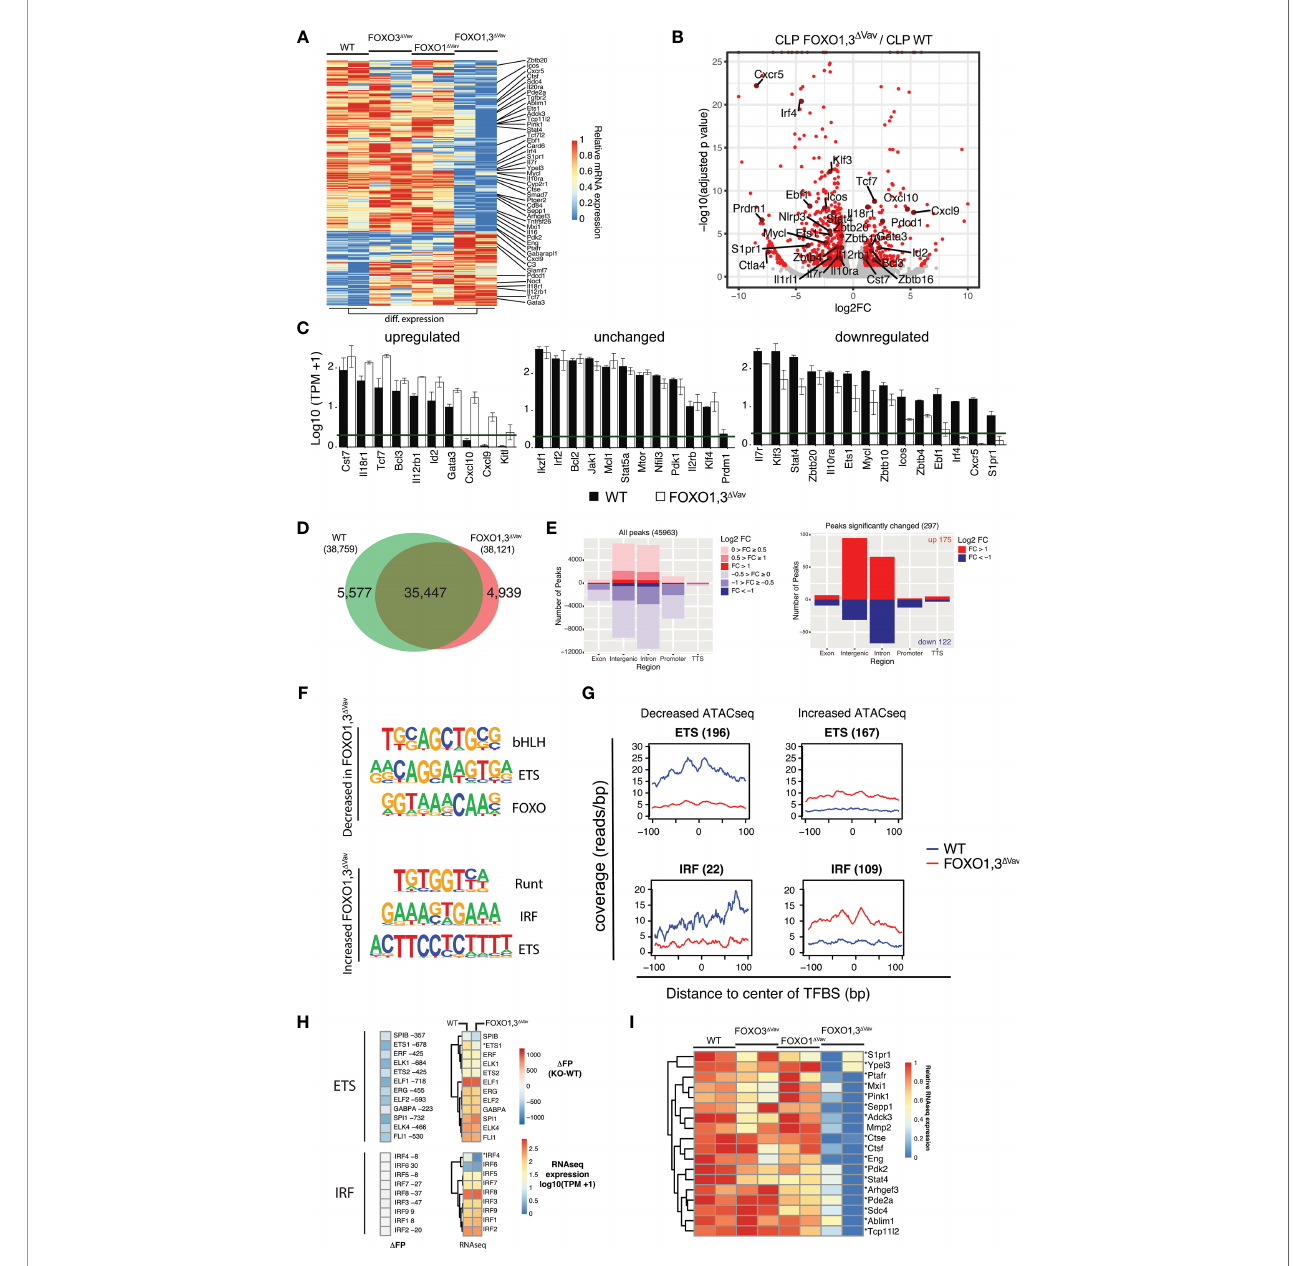
FIGURE 5 | Removal of FOXO results in NK associated gene regulatory changes at the CLP stage. (A) Heatmap showing row normalized expression of genes with differential expression (adjusted p-value ≤ 0.01, ≥ 2-fold change in expression and ≥ 1 TPM in 2+ samples) between WT and FOXO1,3 D Vav LY6D neg CLPs. (B) Volcano plot showing log2 fold change and adjusted p-value for the comparison of WT to FOXO1,3 D Vav LY6D neg CLPs. Red dots indicate genes with >2-fold change in expression and adjusted p-value < 0.05. (C) Bar graphs showing expression (TPM) of select NK associated genes. Genes with adjusted p-value ≤ 0.01, ≥ 2-fold change in expression and ≥ 1 TPM in 2+ samples were considered to have the decreased or increased expression. The green line indicates 1 TPM. (D) Venn diagram showing the overlap between ATACseq peaks identi fi ed in LY6D neg CLPs from WT and FOXO1,3 D Vav mice. Only peaks identi fi ed in ≥ 2 replicas each with >30 reads were considered. (E) Annotation of all ATAC-seq peaks identi fi ed (left) and peaks with signi fi cantly altered chromatin accessibility (adjusted p-value < 0.01 and ≥ 2-fold change in signal) when comparing LY6D neg CLPs from WT and FOXO1,3 D Vav mice (right). Number of regions and log2 fold change (FOXO1,3 D Vav /WT) in ATAC-seq signal is indicated. (F) Motifs enriched in differential ATAC-seq peaks. Top three most signi fi cantly enriched motifs existing in >10% of regions are displayed. (G) Cut-pro fi les for differential ATAC-seq peaks with ETS- and IRF-family transcription factor binding sites (TFBS). Number of regions with each TFBS is indicated in parenthesis. (H) Genome-wide difference in the number of footprints (identi fi ed in WT and FOXO1,3 D Vav LY6D neg CLPs) (left) and expression (right) of indicated genes from the ETS- and IRF-families. * indicates signi fi cant differences in gene expression between LY6D neg CLPs from WT and FOXO1,3 D Vav mice. (I) Expression of known ETS1 targets in LY6D neg CLPs from mice with indicated